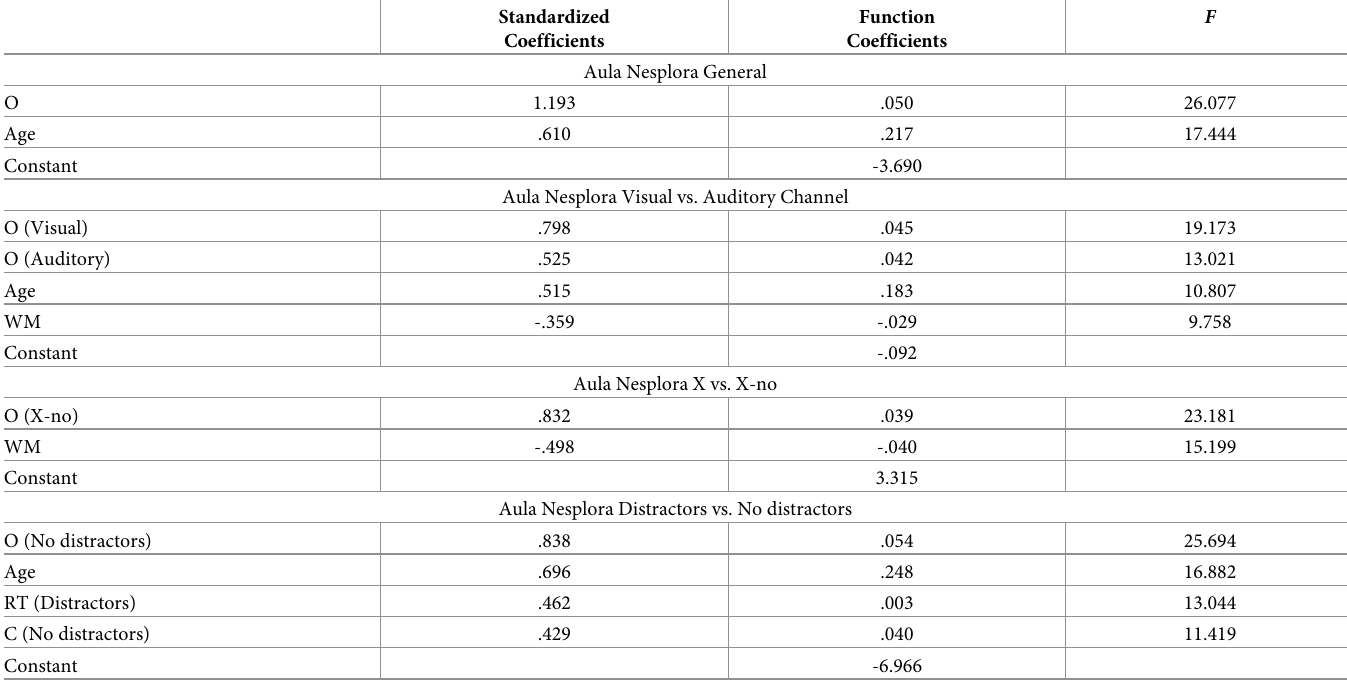
Table 4. Results of discriminant analyses, using stepwise method. Analyses with Aula Nesplora general variables, and for pairs of